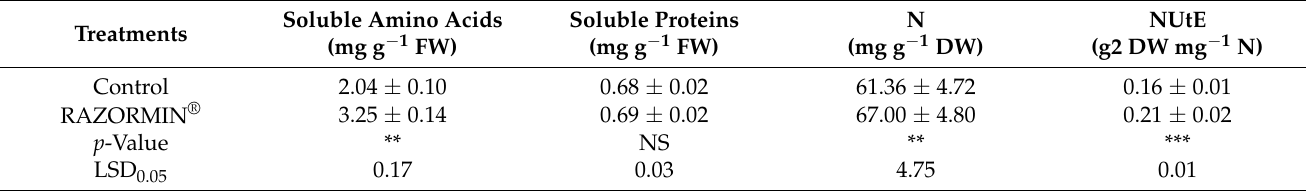
Table 4. Effect of RAZORMIN ® application on foliar concentration of amino acids and soluble proteins, total nitrogen (N), and N utilization efficiency (NUtE).